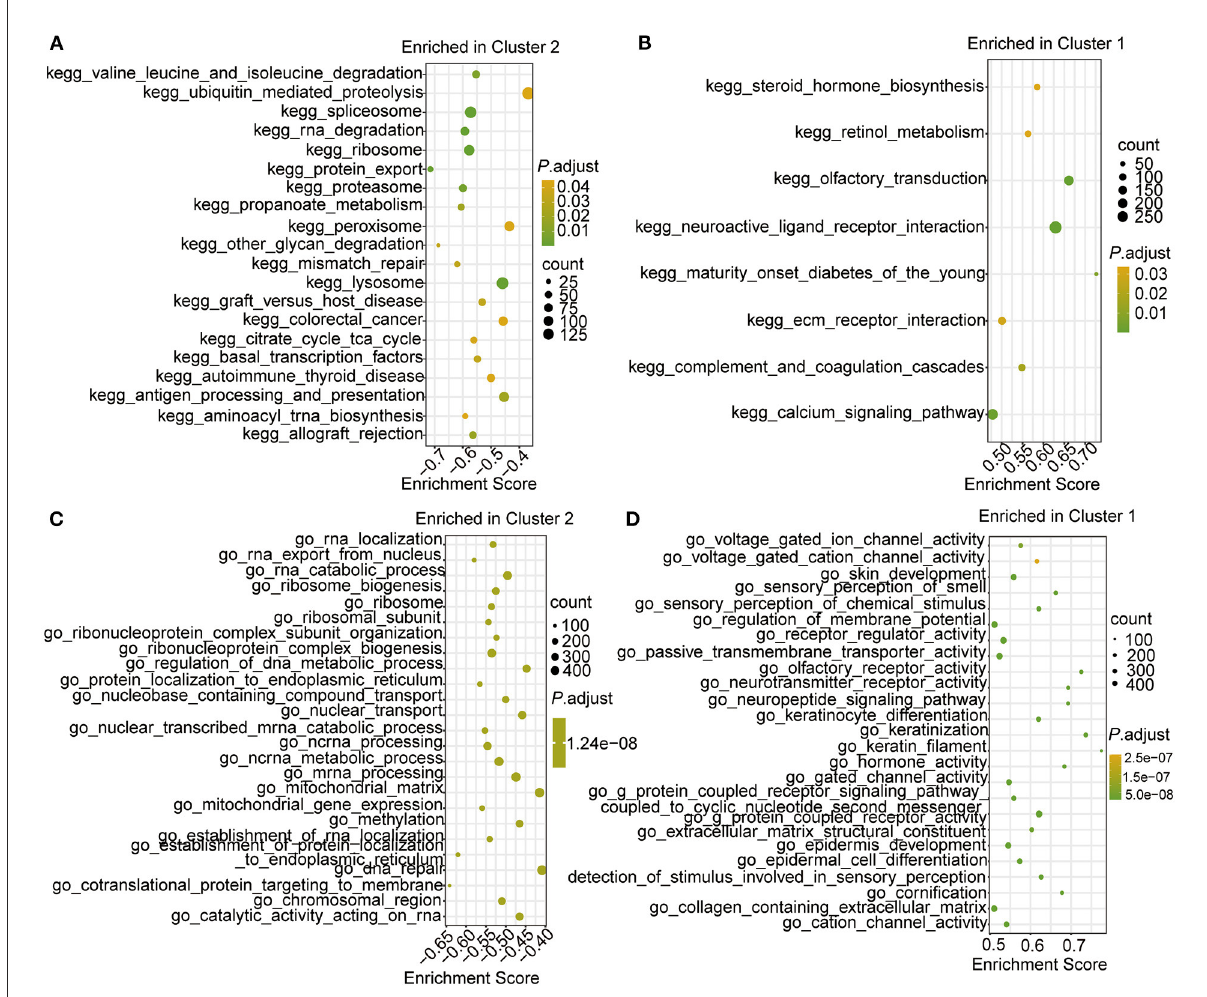
FIGURE6 The GSEA enrichment analysis in the two clusters. (A,B) Top 10 GSEA-KEGG enrichment of genes in cluster 2 (A) and cluster 1 (B) . (C,D) Top 10 GSEA-GO enrichment of genes in cluster 2 (C) and cluster 1 (D)